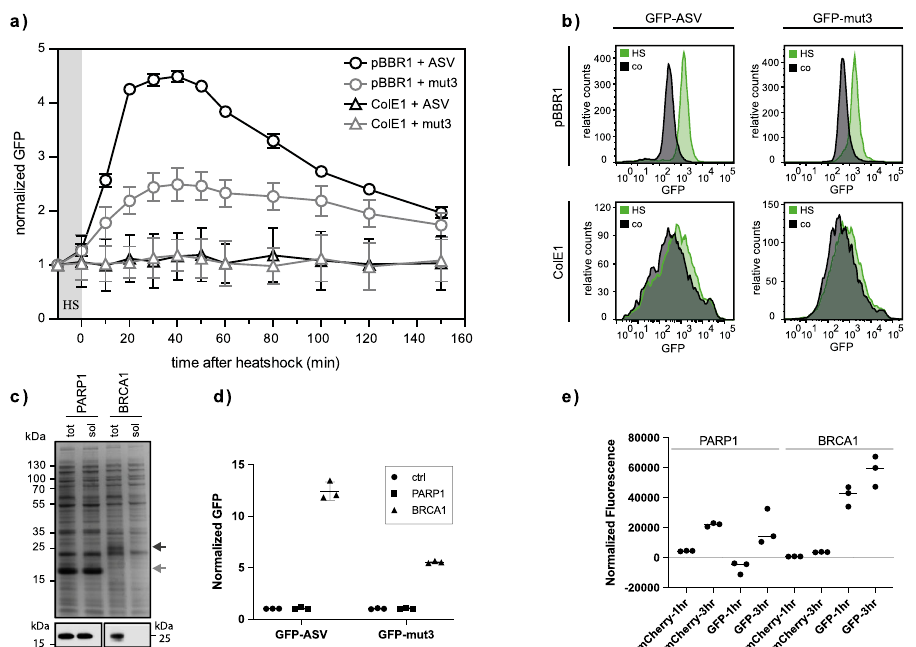
Fig. 2 Optimization and test of the protein folding sensor plasmid to improve differentiation of heat shock response signals. a Monitoring of the heat shock response signals of protein folding sensors (pSEVA441-IbpAp and pSEVA631(Sp)-lbpAp) with different origin of replications (ColE1 and pBBR1, respectively) and GFP variants (GFP-mut3 and GFP-ASV) after induction of the lbpA promoter. Changes in the GFP signal after induced heat shock (HS) are monitored using fl ow cytometry and the GFP signals in triplicates (average ± SD) are normalized to the respective background signal at each time-point. b FACS pro fi les for the GFP signals 60 min after induced heat shock for GFP-mut3 and GFP-ASV in plasmids with different origin of replications. Relative counts of GFP fl uorescence intensities are shown from the analysis of 10,000 single cells. The heat shock induced (HS) GFP variants expressed from pBBR1 (pSEVA631(Sp)-lbpAp) shows well-de fi ned and distinct peaks, which are easy to distinguish from the un-induced control plasmids (co). The GFP